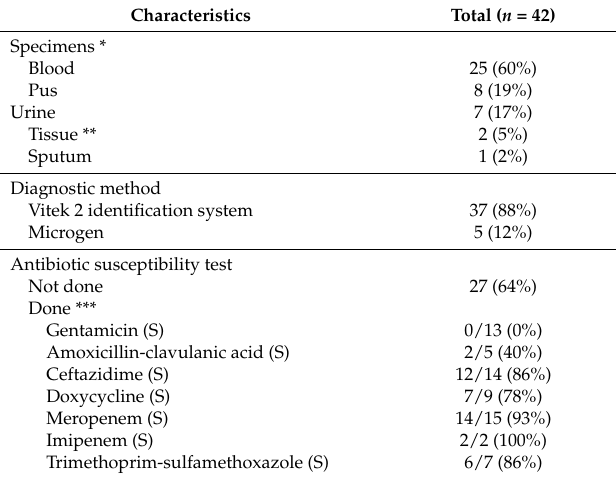
Table 4. Specimens, diagnostic method and reported but unverified antibiotic susceptibility test results in 42 culture-confirmed melioidosis cases with available clinical data from 2012 to 2017.